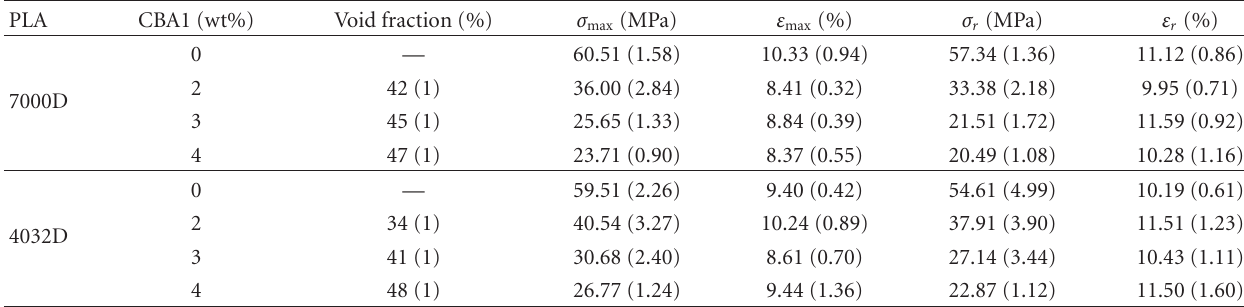
Table 14: PLA-foams tensile properties as a function if the chemical blowing agent content (CBA1) (PLA 7000D temperature profile A and PLA 4032D temperature profile B; screw speed 30 rpm; die temperature 195 ◦ C; free cooling)— σ max : yield stress, ε max : elongation at